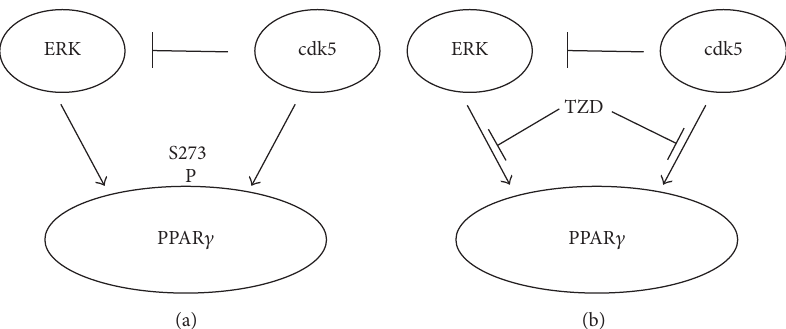
Figure 1: (a) Phosphorylation of PPAR 𝛾 by ERK and CDK5 which also suppresses ERK Kinase. (b) TZD blocking the access of ERK and